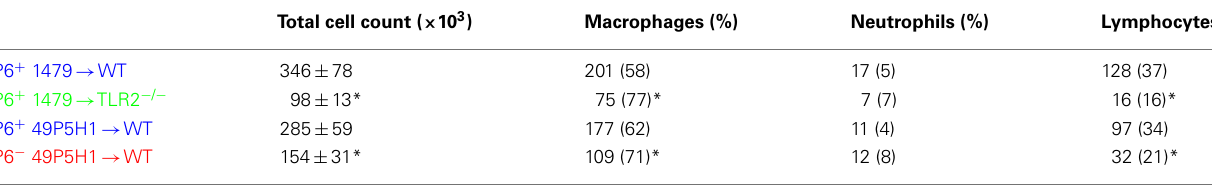
Table 2 | Immune cell composition in bronchoalveolar lavage fluid.